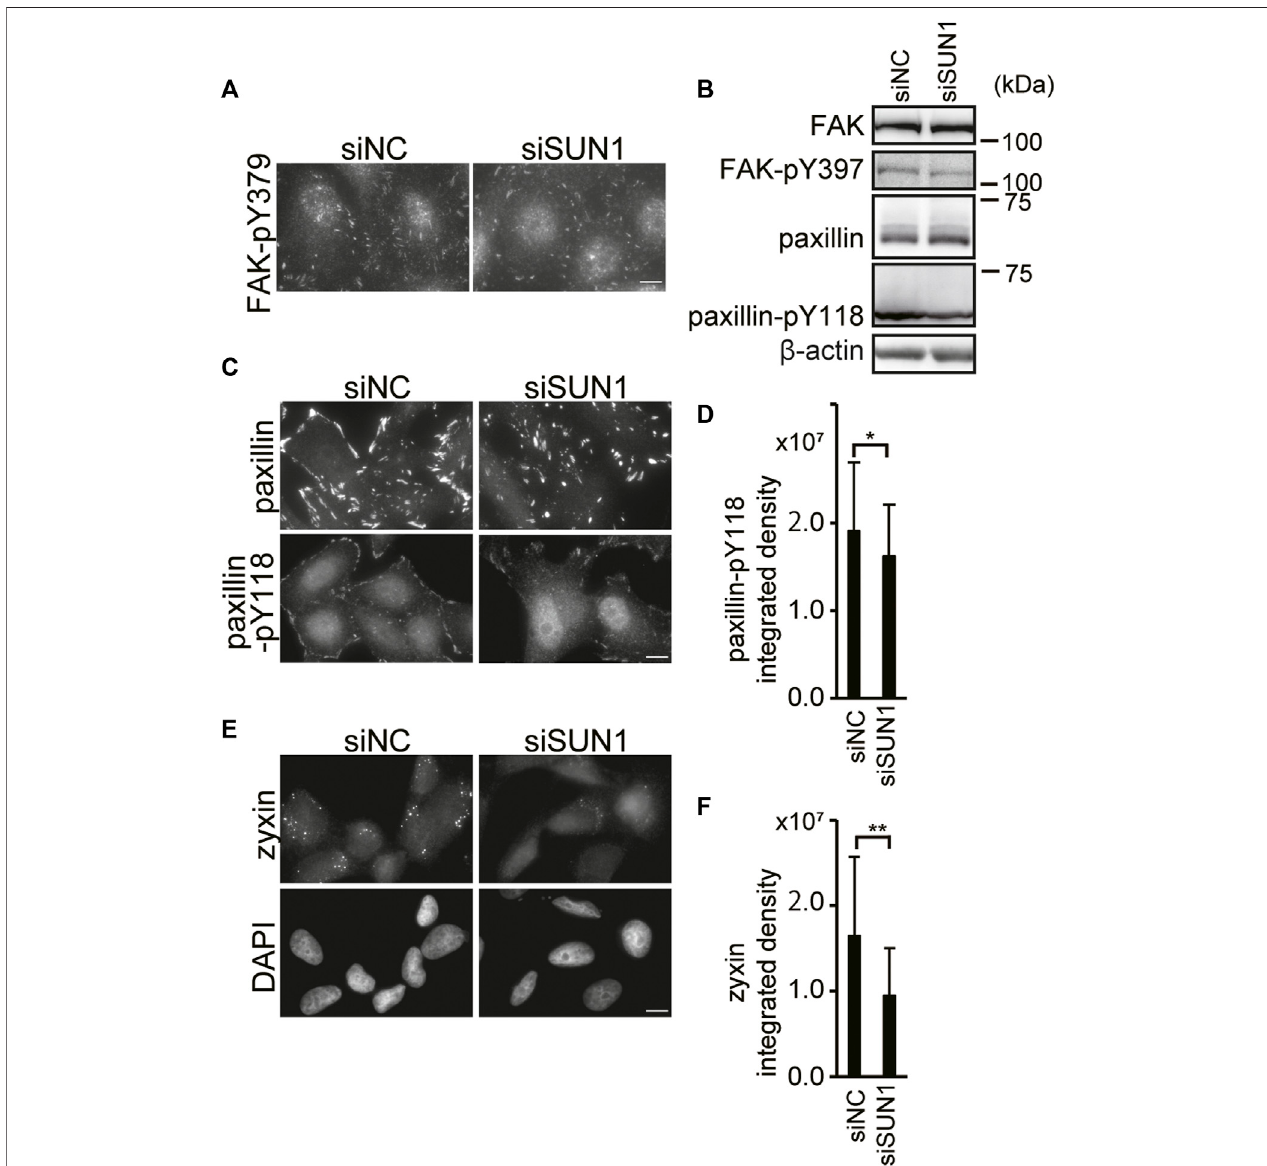
FIGURE 3 | SUN1 depletion suppresses FA maturation. (A) Cells were transfected with siSUN1 or siNC. Next, the cells were fi xed and stained with anti-Tyr379 phosphorylatedFAKmAb.Scalebar,10 μ m. (B) CellsweretransfectedwithsiSUN1orsiNC. Afterward,thecelllysatewasanalyzedbywesternblottingusinganti-FAK, anti-FAK-pY397, anti-paxillin, anti-paxillin-pY118, and anti- β -actin mAbs. (C) Cells were transfected with siSUN1 or siNC and stained with anti-paxillin or anti-paxillin- pY118 mAb. Scale bar, 10 μ m. (D) The integrated density of the Tyr118 phosphorylated paxillin staining was quanti fi ed using the ImageJ software. The values representthemean±standarddeviation(SD).* p < 0.05comparedwithsiNC-transfectedcells. (E) CellsweretransfectedwithsiSUN1orsiNC.Next,thecellswere fi xed and stained with anti-zyxin mAb. Bar, 10 μ m. (F) The integrated density of the zyxin staining was quanti fi ed. The values represent the mean ± standard deviation (SD). ** p < 0.01 compared with siNC-transfected